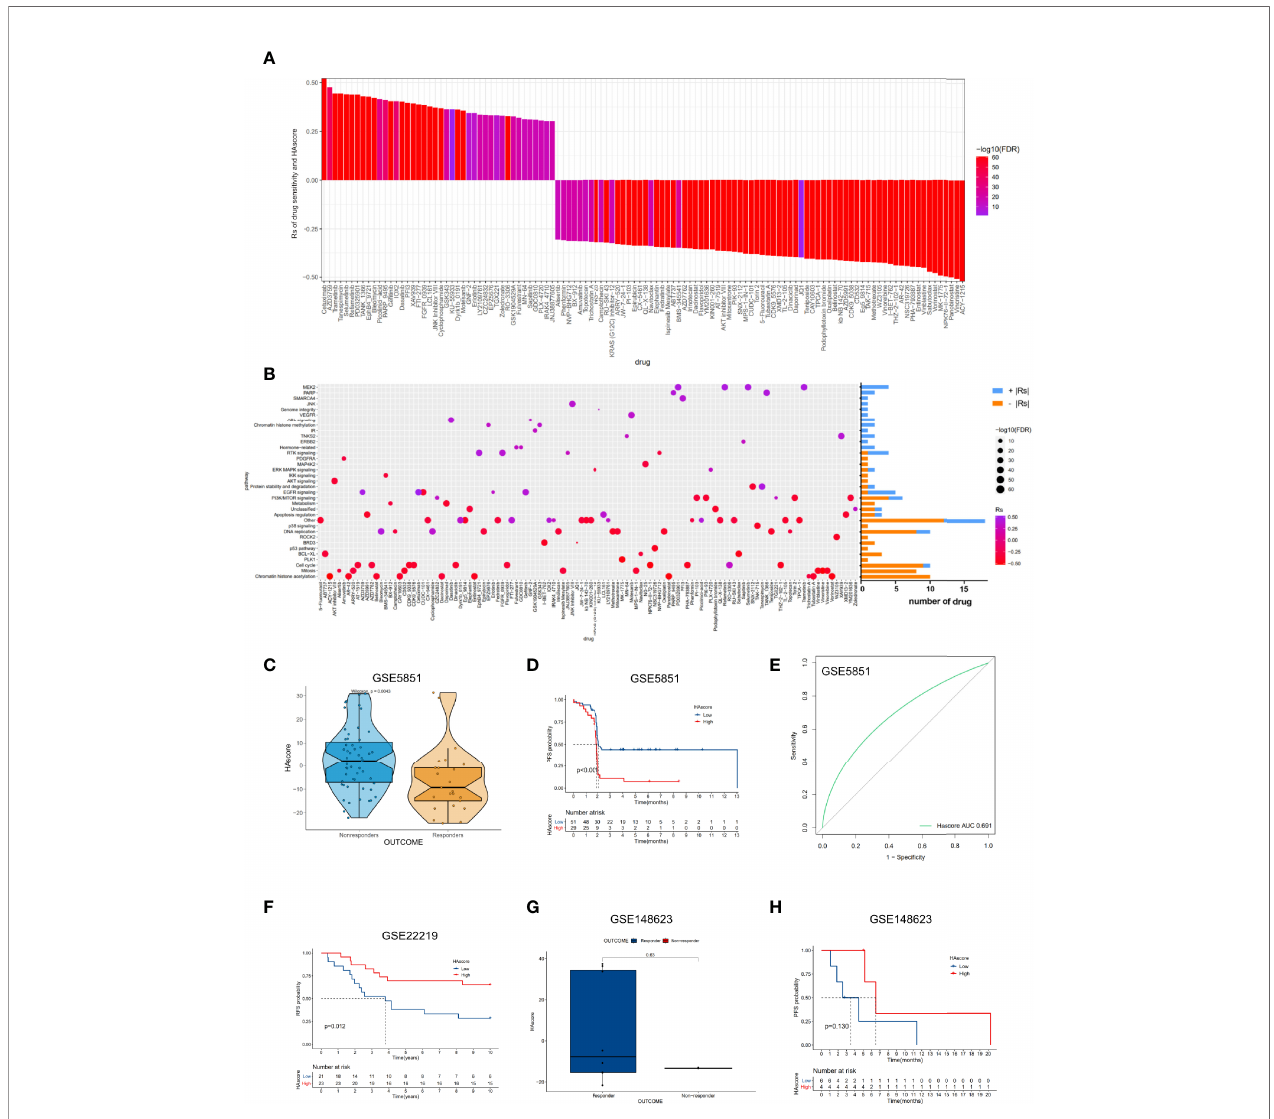
FIGURE 6 | The relationship between HAscore and drug sensitivity. (A) The Spearman analysis was used to evaluate the correlation between HAscore and AUC of drug-sensitive curve. The brightness of column indicates the signi fi cance of the correlation. The height indicates the values of Rs. (B) Signaling pathways targeted by drugs that were closely correlated with HAscore. The horizontal axis shows the drug names, and the vertical axis shows the signaling pathway targeted by the drugs. The bar graph on the right displays the number of drugs in each signaling pathway. The signi fi cance of the correlation is shown by the size of the point. (C, G) The difference of HAscores between distinct clinical outcomes of related anti-tumor drugs, including cetuximab (C) and ricolinostat (G) . (D, F, H) Kaplan – Meier curves show the overall survival time in high HAscore or low HAscore group after the treatment of related anti-tumor drugs, including cetuximab (D) , a cyclophosphamide, methotrexate, and 5- fl uorouracil regimen (F) , and ricolinostat (H) . (E) The predictive value of the HAscore to the sensitivity of cetuximab (AUC =